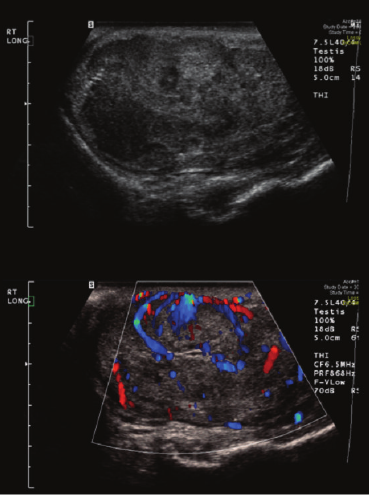
Figure 1: Right testicular ultrasound, showing a testicular mass with flow on Doppler.